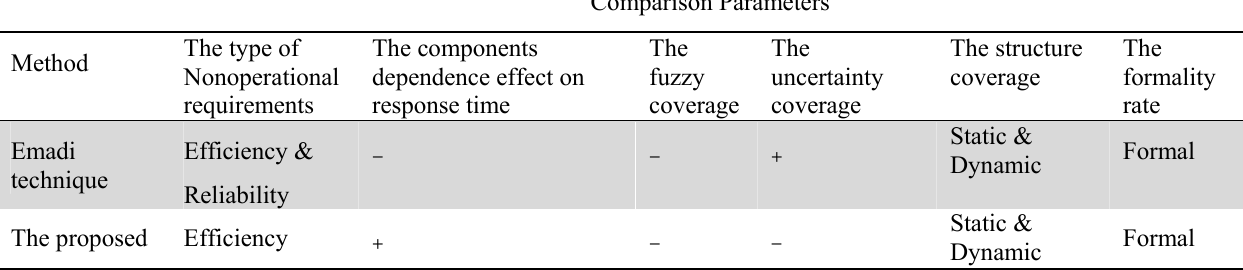
A comparison of